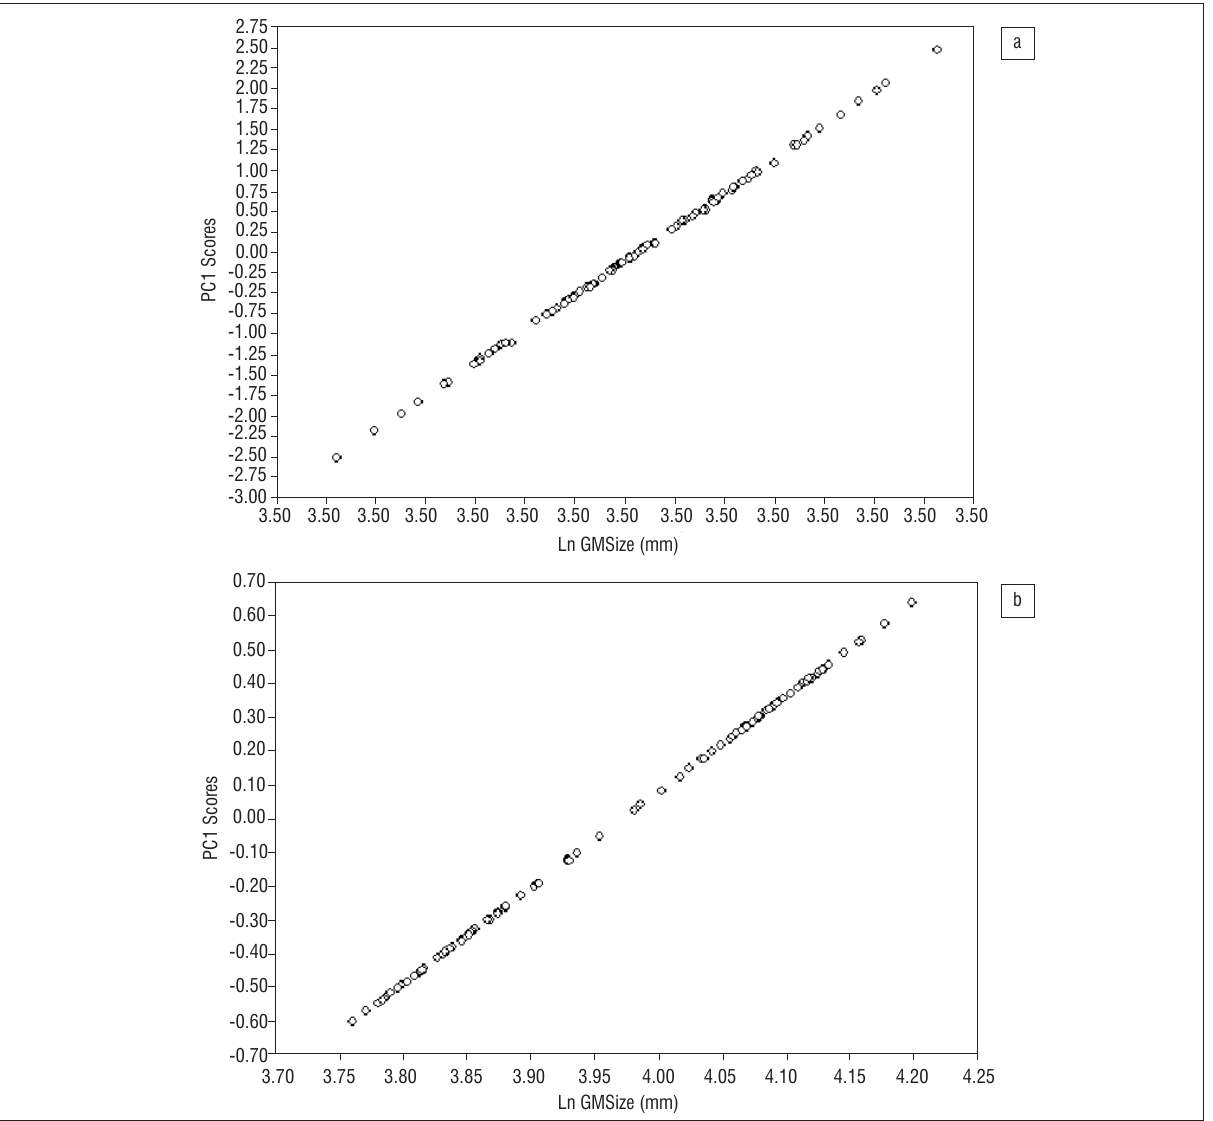
Figure 4: Bivariate scatter plots of PC1 scores ( y -axis) against GMSize of the k =8 postcranial variates in (a) Pan t. troglodytes and (b) Gorilla g. gorilla . In both cases the parametric correlation (Pearson’s) is r =1.00. Component loadings for principal component (PC) analysis axes: African hominids